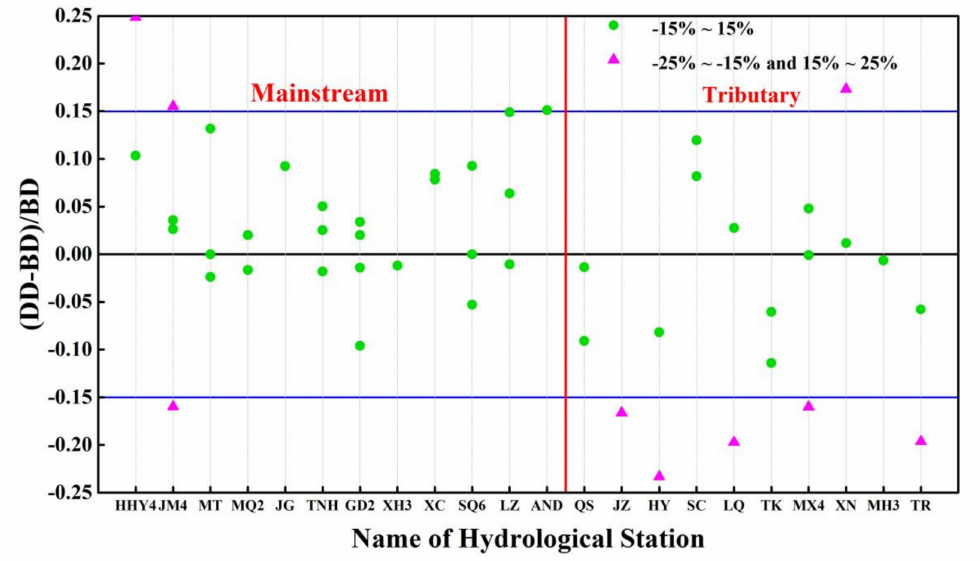
Figure 4. The ratios of the daily discharges to bankfull